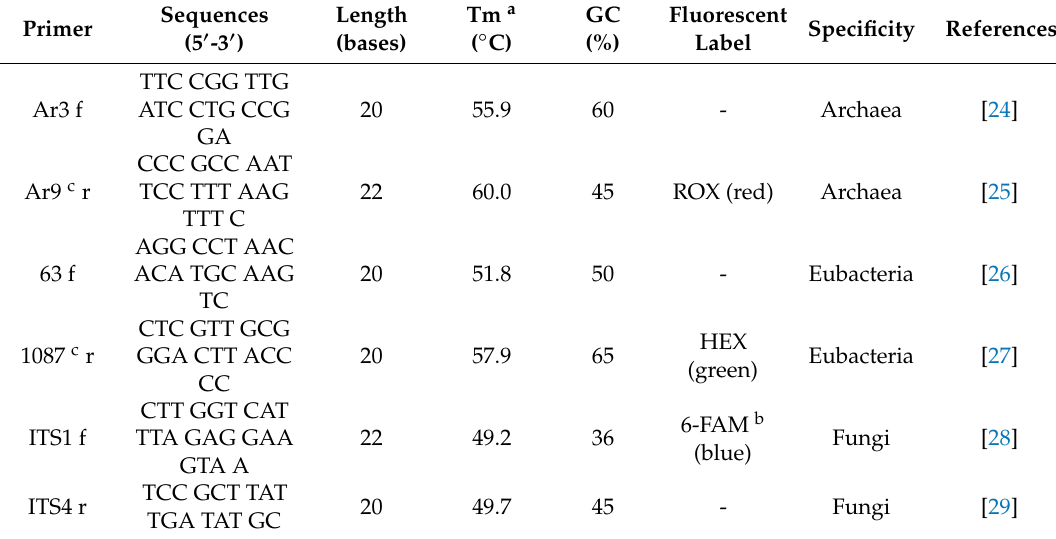
Table 1. Primers used for single and multiplex PCR.